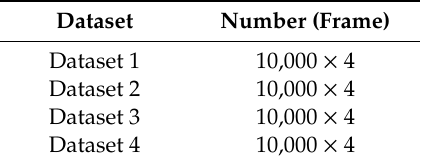
Table 3. Capacity of the dataset.